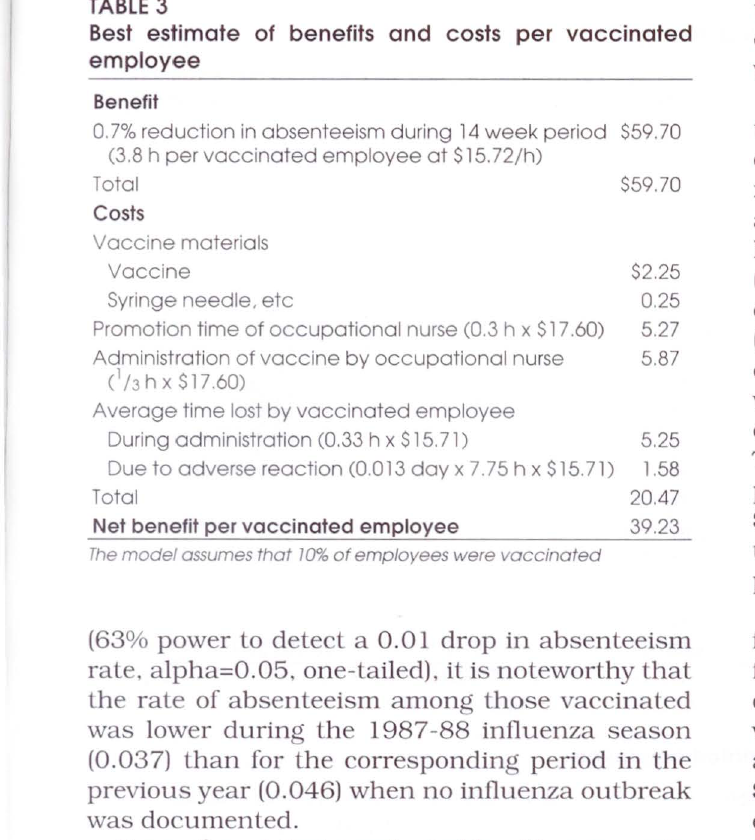
Best estimate of benefits and costs per